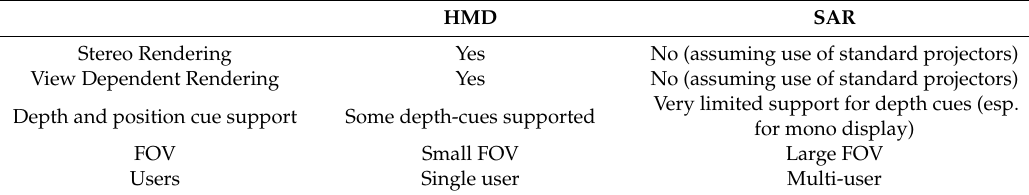
Table 1. Pros and cons of HMDs versus spatial augmented reality